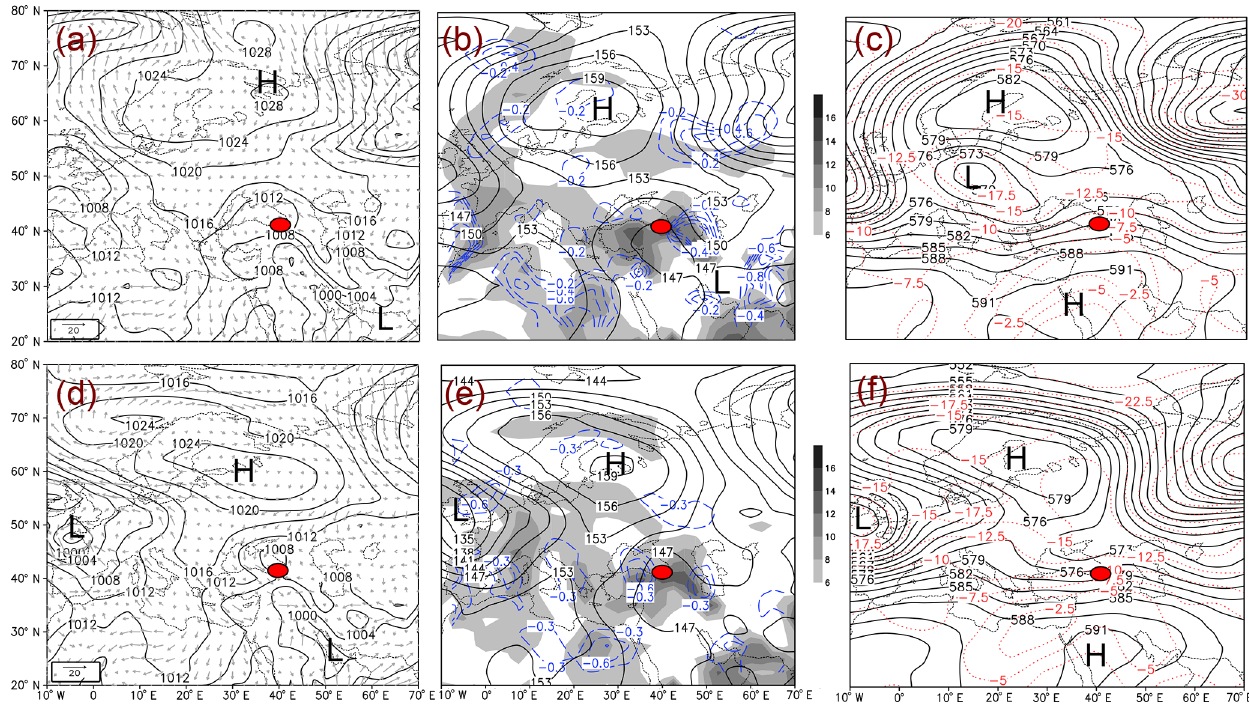
Figure 5. (a) Sea-level pressure chart (lines, units in hPa) and surface winds (arrows, units in ms − 1 ). (b) Geopotential height field (units in dm), specific humidity contents (shaded in colors, units in gkg − 1 ), and moisture convergence values (dashed lines, removed positive values) of the 850hPa level. (c) Geopotential height field (units in dm), and temperature values (dashed red lines in ◦ C) of the 500hPa level. Synoptic charts are from the 23 August 2015, 00:00UTC. The data of surface, lower and upper levels are derived from NCEP/NCAR reanalysis. Red dot marks the studied region. Panel (d) is the same as (a) , (e) is the same as (b) , and (f) is the same as (c) , but for 24 August 2015, 00:00UTC.